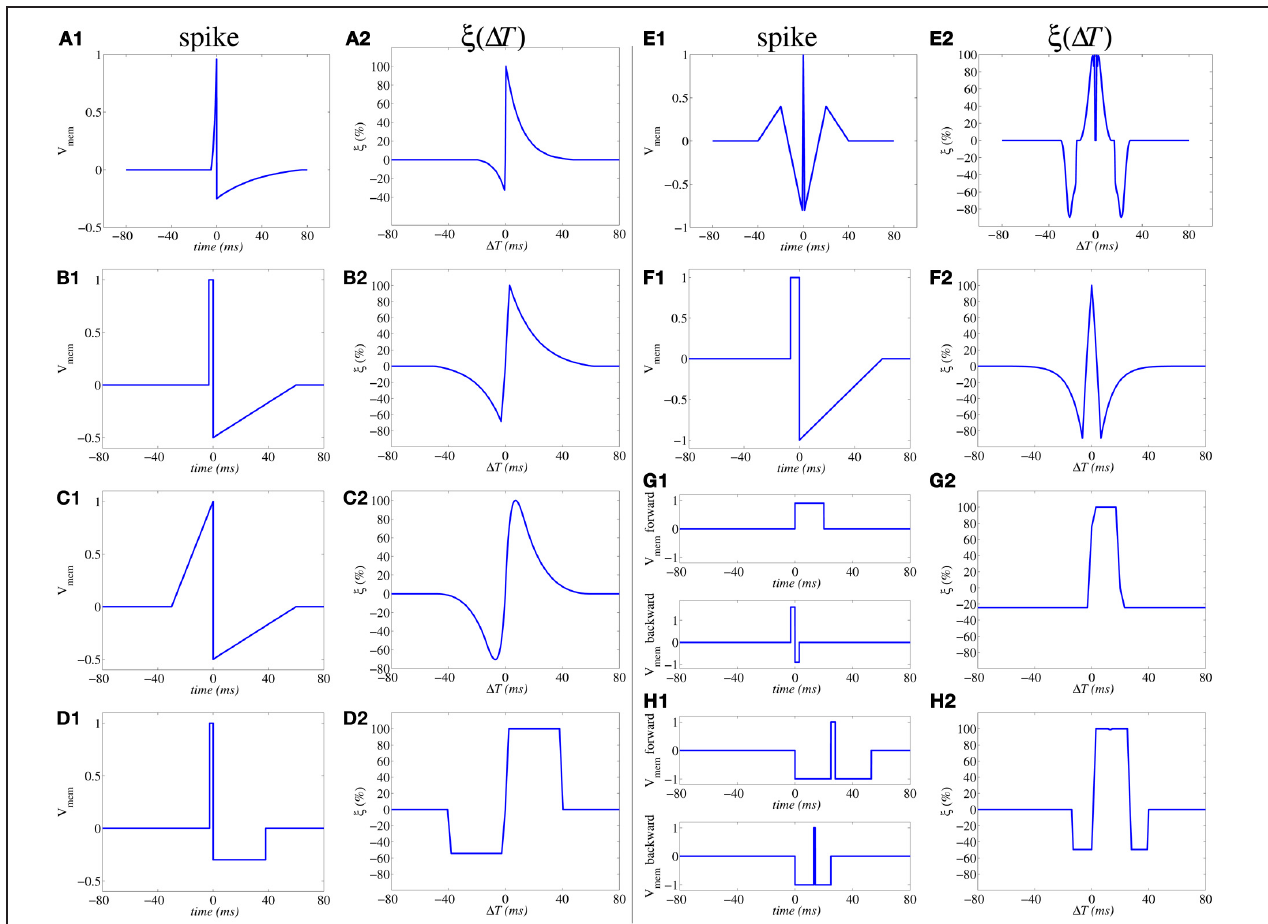
FIGURE 4 | Illustration of influence of action potential shapes on the resulting STDP memristor weight update function ξ ( (cid:2) T ). Memristor upper and lower thresholds are normalized to amplitudes ± 1.0. From (A1,A2) to (E1,E2) the same spike waveform travels forward and backward. In (F1,F2) the forward and backward waveforms are the same but have opposite